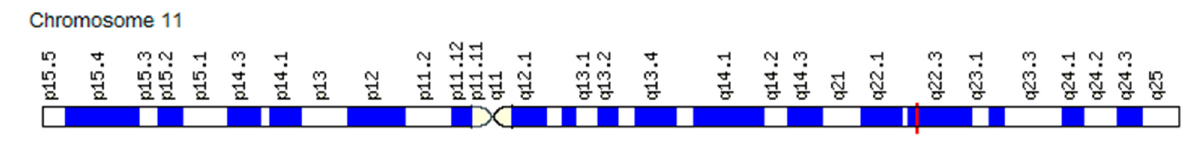
Figure 5. Localization of the PDGF-D gene on chromosome 11q22.3.